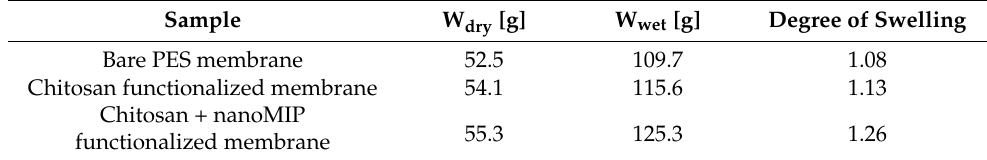
Table 1. Swelling degrees of PES membranes at main steps of membrane preparation.